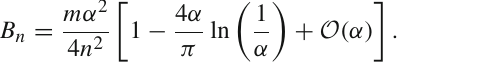
Fig. 2 Spectrum of the W-C model as a function of the coupling con- stant λ( B ) in the low energy limit. Upper panel corresponds to n=1 states with different values of κ = 0 , 1 ,.. . The case κ = 0 is compared to the non relativistic solution. Horizontal lines correspond respectively tothemaximalvaluesofthecouplingconstantforawell-definedground state ( λ = 2) and to the minimal value for which the abnormal solutions exist ( λ = 1 / 4). Lower panel contains the full spectrum for n ≤ 6 and κ ≤ 3 to make explicit the different crossings. Notice that the unphys- ical solutions with odd κ (giving no contribution to the S-matrix) are naturally inserted in the spectrum